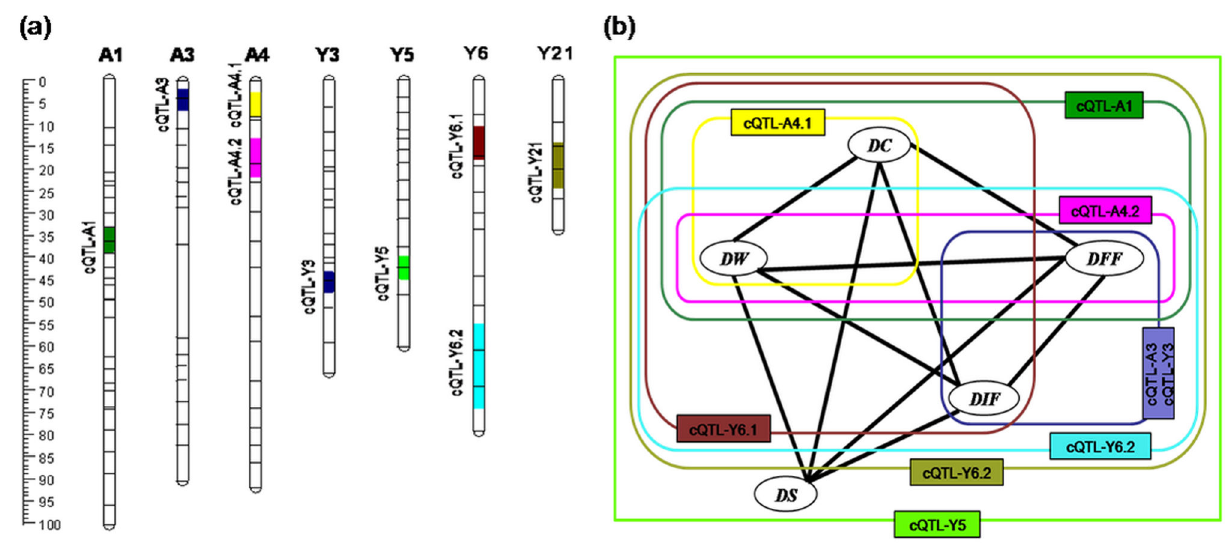
Figure 2. The clustered QTL and their relationship to the inter-related flowering time traits. (a) Distribution of clustered additive QTL on the linkage maps. The bar on the left shows the scale in cM. (b) Correlations between flowering time traits and the clustered QTL underlying these traits. Significantly correlated traits (P < 0.01) are connected by thick lines. Days from transplanting to squaring (DS), coloring (DC), initial flowering (DIF), full flowering (DFF) and inflorescence wilting (DW). doi: